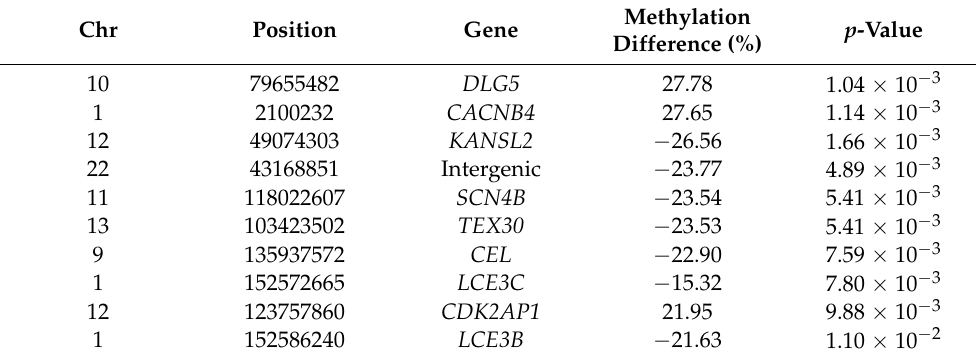
Table 3. List of top ten differentially methylated regions (DMRs) associated with current suicidal ideation. These regions were identified to be the most differentially methylated between subjects with and without current suicidal ideation.